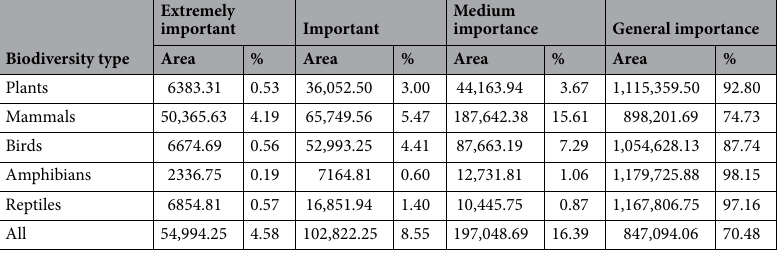
Table 1. Area (km 2 ), and its proportion (%) to total area with different levels of importance for biodiversity conservation in